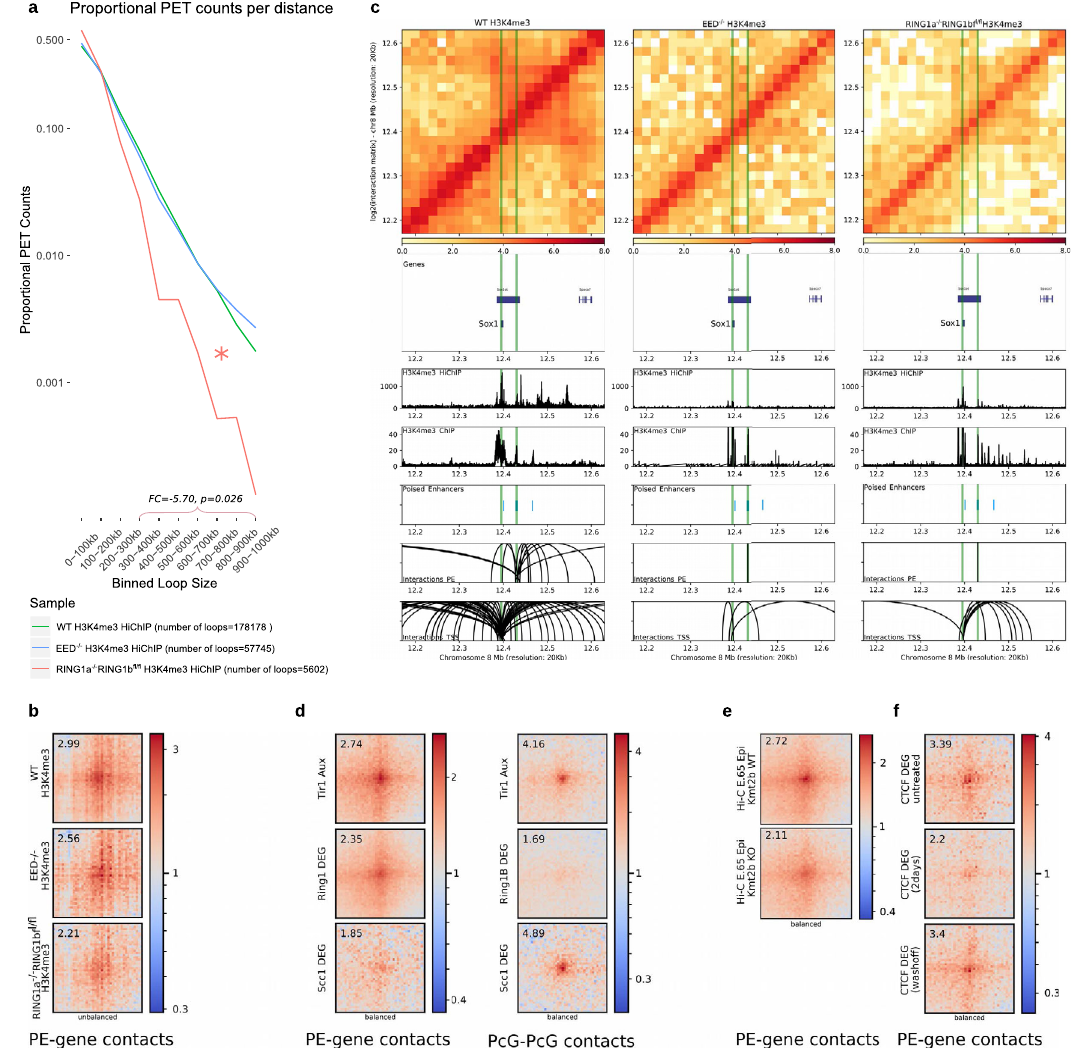
Fig. 4 Protein complexes controlling the interactions between PEs and bivalent promoters in mESC. a Signi fi cant ( q < 0.1; FitHiChIP) H3K4me3 HiChIP interactions identi fi ed in WT mESC, Eed − / − mESC and Tamoxifen-treated Ring1a − / − Ring1b fl / fl mESC were plotted according to their loop size. Mid-range (300kb-1mb) loops are signi fi cantly reduced (FC = − 5.70, p = 0.026; two-sided Wilcoxon test) in Tamoxifen-treated Ring1a − / − Ring1b fl / fl mESC compared to WT. PET = paired-end tags. b Signi fi cant (mESC H3K27me3 HiChIP data; p < 0.01; FitHiChIP) interactions between distal PEs (>10 kb from TSS) and bivalent promoters ( n = 526) were visualized as pileup plots using H3K4me3 HiChIP data generated in WT, Eed − / − and Tamoxifen-treated Ring1a − / − Ring1b fl / fl mESC. HiChIP interaction matrices were coverage-normalized (unbalanced). c H3K4me3 HiChIP in WT, Eed − / − mESC, and Tamoxifen-treated Ring1a − / − Ring1b fl / fl mESC around the Sox1 locus. d Signi fi cant (mESC H3K27me3 HiChIP data; p < 0.01; FitHiChIP) interactions between distal PEs (>10 kb from TSS) and bivalent promoters (left panel; n = 526) or between PcG domains (right panel; n = 411) were visualized as pileup plots using Hi-C data generated in the following mESC lines expressing Tir1 and treated with Auxin 52 : WT mESC ( Tir1 Aux), Ring1a − / − Ring1b DEG/DEG mESC (i.e. RING1A/B- depleted cells; Ring1b Aux) and Rad21/Scc1 DEG/DEG mESC (i.e. Cohesin depleted cells; Scc1 Aux). Hi-C interaction matrices were KR-balanced (balanced). e Signi fi cant (mESC H3K27me3 HiChIP data; p < 0.01; FitHiChIP) interactions between distal PEs (>10 kb from TSS) and bivalent promoters ( n = 526) were visualized as pileup plots using Hi-C data generated in the epiblast from WT and Kmt2b/Mll2 − / − E6.5 mouse embryos 51 . Hi-C interaction matrices were KR-balanced (balanced). f Signi fi cant (mESC H3K27me3 HiChIP data; p < 0.01; FitHiChIP) interactions between distal PEs (>10 kb from TSS) and bivalent promoters ( n = 526) were visualized as pileup plots using Hi-C data generated in CTCF-Degron mESC lines 53 that were either untreated (CTCF untreated), treated with Auxin for two days (CTCF Aux (2 days)) or treated with Auxin and then washed off (CTCF Aux (washoff)). Interaction matrices were KR- balanced (balanced). In ( b , d – f ), HiChIP or Hi-C pairwise interactions are shown 250 kb up- and downstream of each PE and bivalent promoter pair. The numbers in the upper left corners correspond to “ loopiness ” values (center intensity normalized to the intensity in the